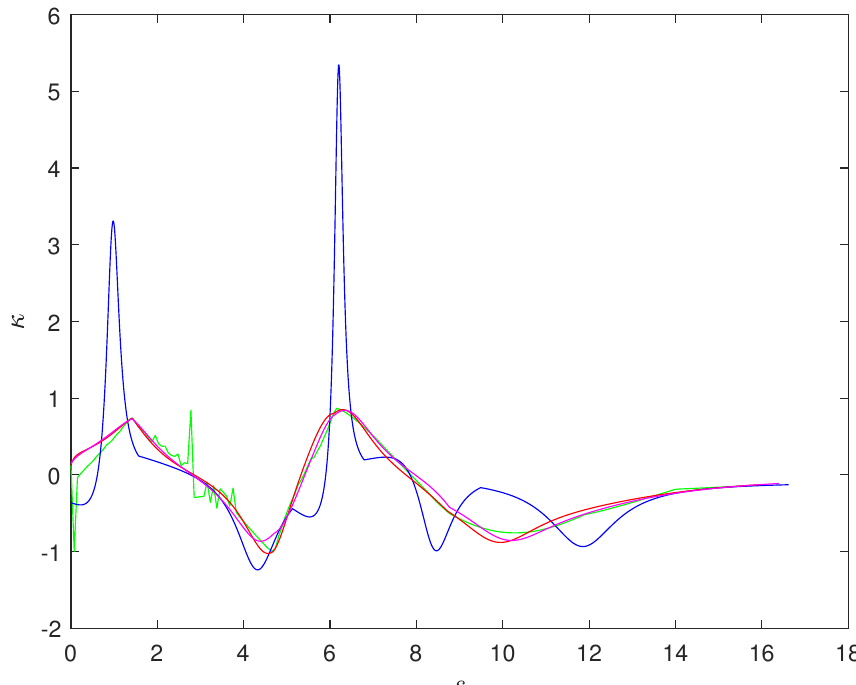
Figure 8. Example 2: the curvature as a function of the curve length s . The colours correspond to the ones in Figure